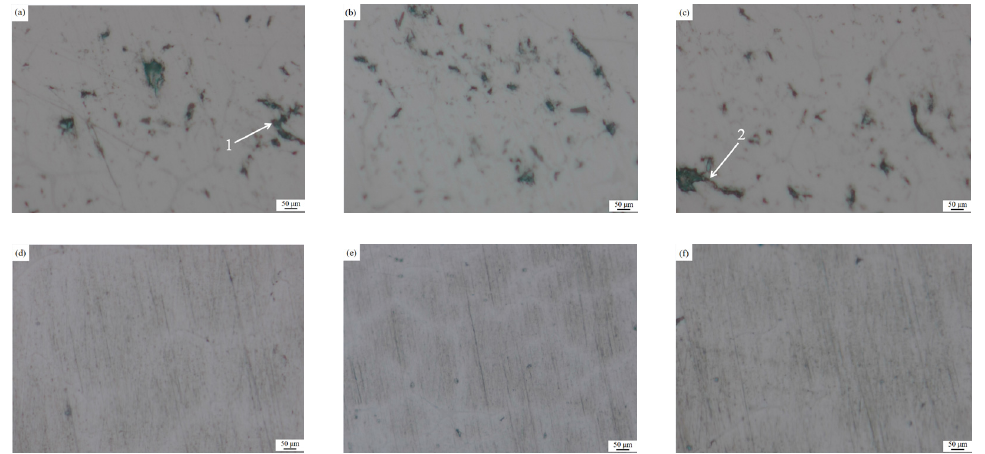
Figure 5. Metallographic pictures of melt specimens before and after ultrasonic purification treatment: ( a ) Specimen 1 (before treatment) ( b ) Specimen 2 (before treatment) ( c ) Specimen 3 (before treatment) ( d ) Specimen 4 (after treatment) ( e ) Specimen 5 (after treatment) ( f ) Specimen 6 (after treatment).